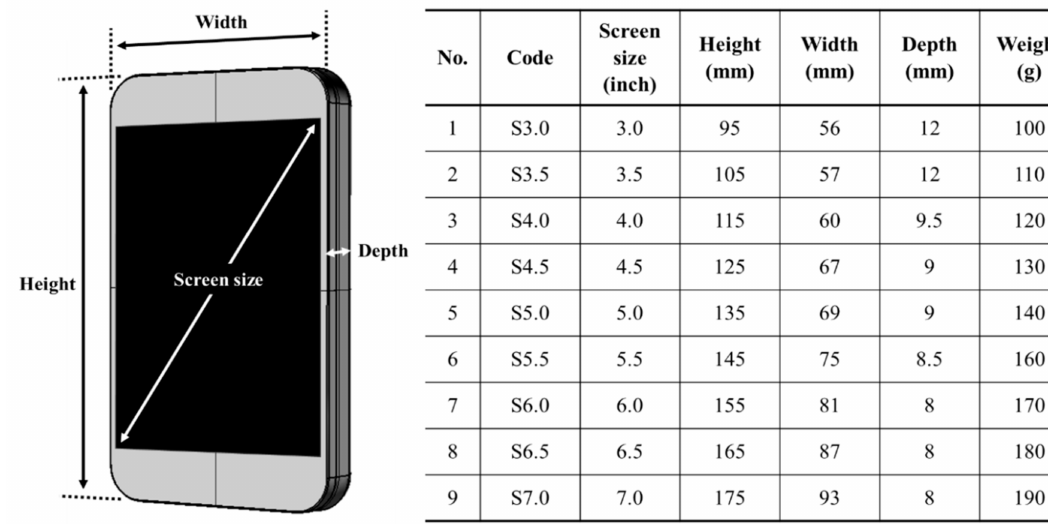
Figure 2. Diagram of a smartphone mockup and the specifications of nine smartphone mockups used in the grip posture